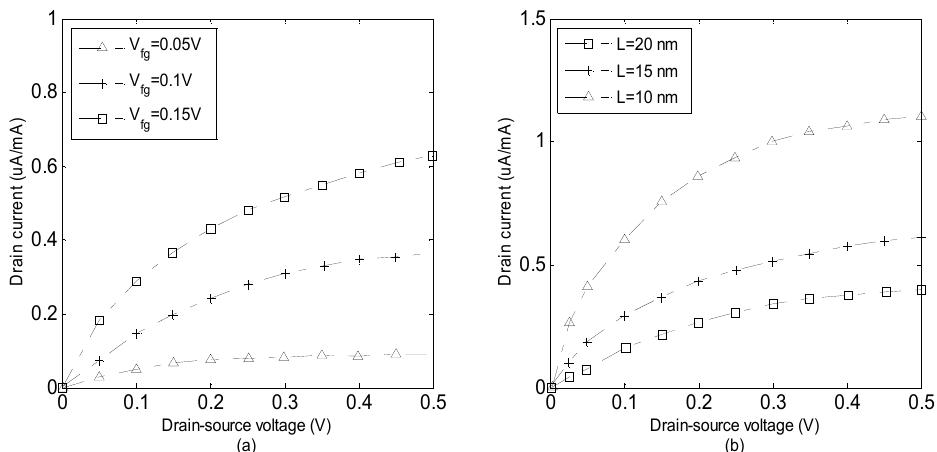
Figure 8. Current-voltage characteristic for different values of ( a ) front gate voltage ( V bg = 0 V, L = 10 nm). ( b ) channel length ( V fg = 0.2 V, V bg = 0 V).